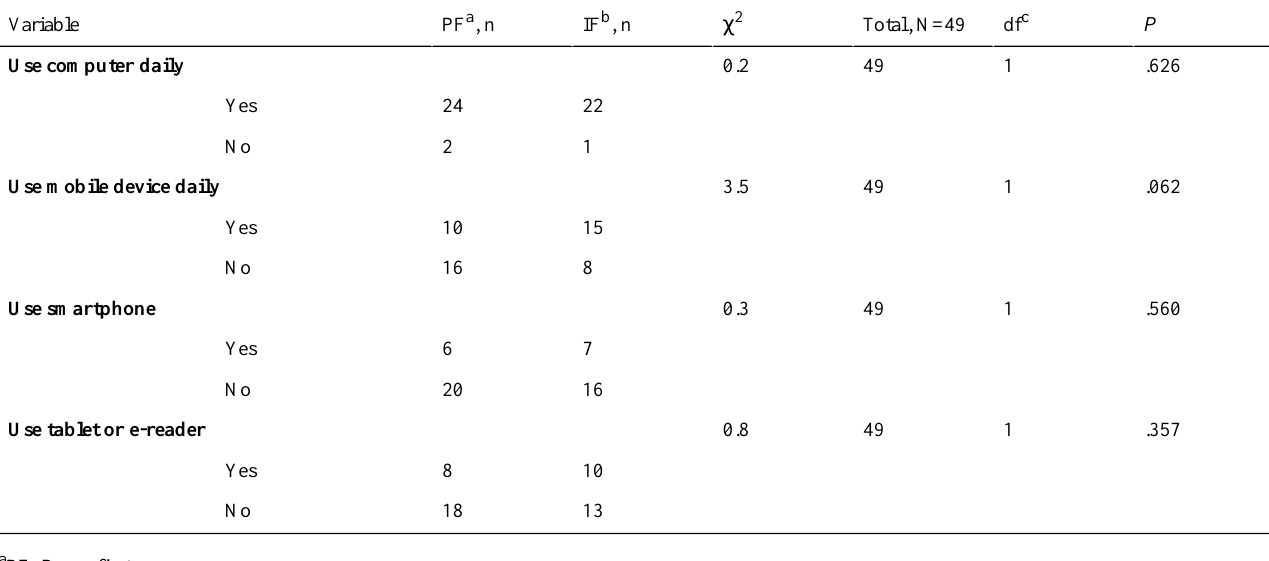
Table 2. Sample device use.